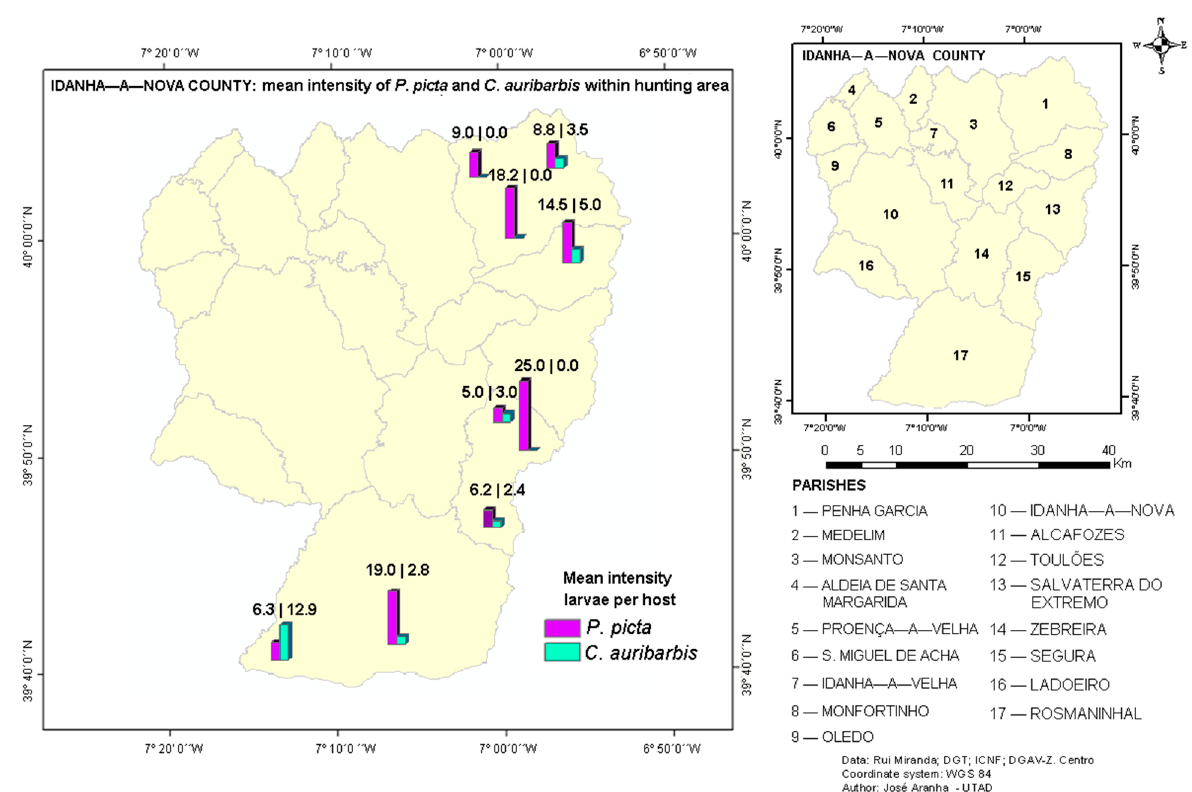
Figure 2. Mean intensity of P. picta and C. auribarbis in each